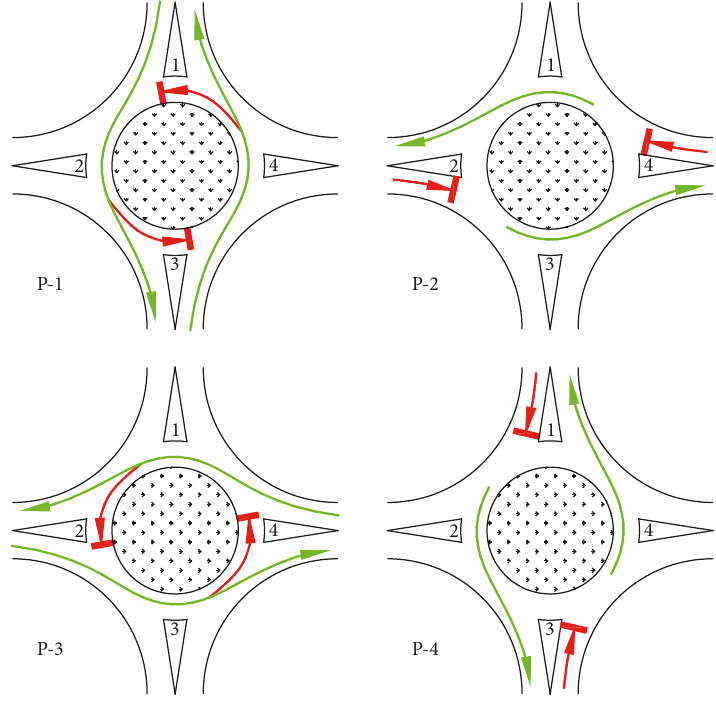
Figure 4: The typical signal phase diagram of a TSLSR.